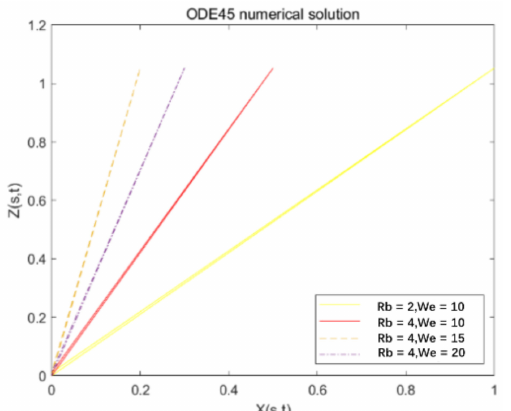
Figure 7. Jet trajectory diagram when the fourth-order Runge-Kutta method of Matlab(version R2016b, accessed on 7 September 2016) solves the Reynolds number and the Weber number are Re = 2, We = 10; Re = 4, We = 10, Re = 4, We = 15; Rb = 4, We = 20.